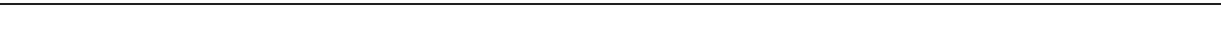
Fig. 2 Irisin promotes skeletal muscle differentiation. a Graph showing the absorbance readings of cells treated with DB (control) or increasing concentrations of irisin (250, 1000, and 2000 ng/ml) at 0, 24, 48, and 72 h of proliferation. Absorbance reading at 655 nm is proportional to the number of cells present and hence, indicative of myoblast proliferation. ( n = 16 biological replicates). b Representative images of H&E-stained myoblasts at 0, 24, 48, 72, and 96 h of differentiation in the presence of DB (control) or irisin (250 and 1000 ng/ml). c Graph showing quanti fi cation of myotube number at 0, 24, 48, 72, and 96 h of differentiation in the presence of DB (control) or irisin (250 and 1000 ng/ml) ( n = 3 biological replicates). d Graph showing quanti fi cation of fusion index at 0, 24, 48, 72, and 96 h of differentiation in the presence of DB (control) or irisin (250 and 1000 ng/ml) ( n = 3 biological replicates). Graphs displaying qPCR analysis of e myomaker and f caveolin-3 expression normalized to GAPDH in differentiating myoblasts (0, 24, 48, 72, and 96 h) treated with DB (control) or irisin (1000 ng/ml) ( n = 3 biological replicates). g IB analysis of MyoD, MHC, myogenin, and p21 protein levels. The levels of GAPDH were assessed as a loading control. Graphs show densitometric analysis of h MyoD, i MHC, j myogenin, and k p21 levels in arbitrary units (a.u), normalized to GAPDH ( n = 3 biological replicates). Since MyoD, MHC, and myogenin IB analysis was performed on the same membrane, the same GAPDH was used to normalize the results. All IBs were performed on proteins collected from differentiating myotubes at 24, 48, 72, and 96 h treated with either DB (control) or irisin (1000 ng/ml). Error bars represent mean ± SEM. One-way ANOVA was performed for all relevant fi gure panels between a and d , and Student ’ s t -test was performed for all relevant fi gure panels between e and k . Signi fi cance is indicated with * p < 0.05 and ** p <